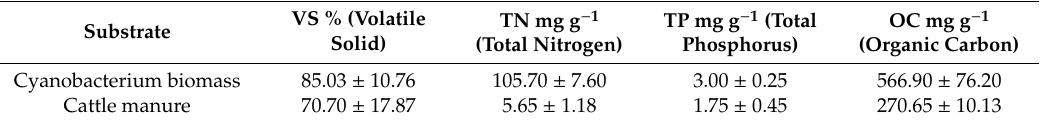
Table 2. Volatile solid, total nitrogen, total phosphorus, and organic carbon of cyanobacterium biomass and cattle manure. Values are average ± SD ( n =